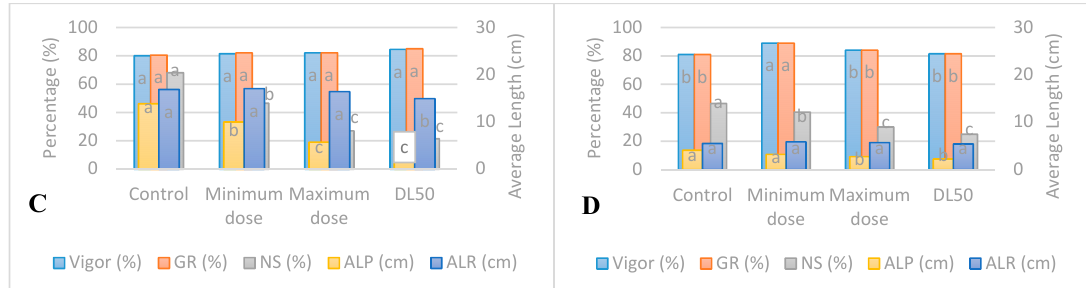
Figure 2. Accelerated aging tests in soybeans, wheat, sunflowers, and pine seedlings under UV-B radiation. ( A ). Glycine Max , ( B ). Triticum aestivum , ( C ). Helianthus annuus , ( D ). Pinus maximartinezii ; GR = germination rate, NS = normal seedlings, ALP = average length of plumule, ALR = average length of radicle. Di ff erent letters in columns with same color indicate significant di ff erences ( p <